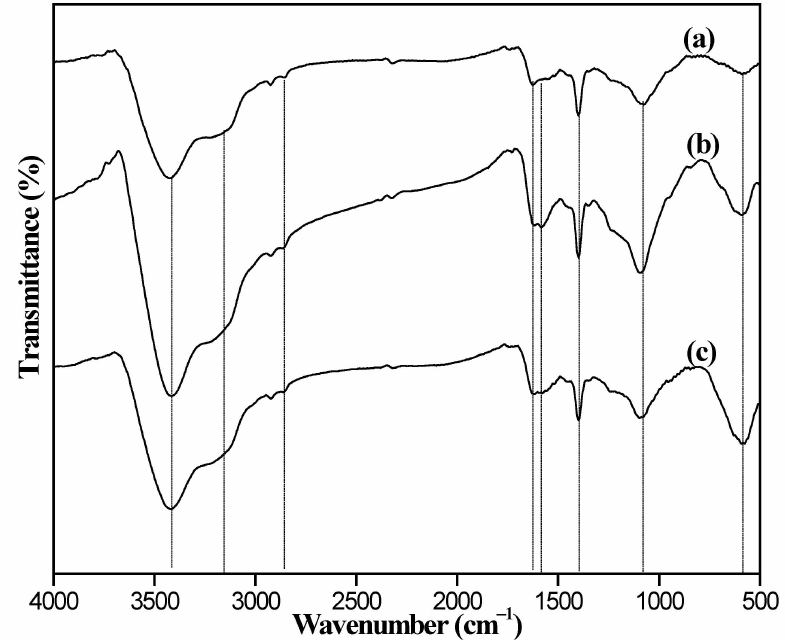
Figure 2. FTIR spectrum of adsorbent samples: ( a ) 6%Fe 3 O 4 @MAC, ( b ) 8%Fe 3 O 4 @MAC, and ( c ) 10%Fe 3 O 4